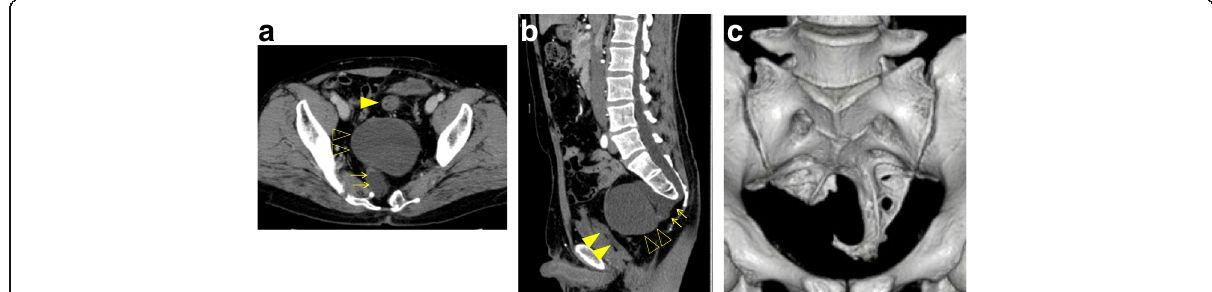
Fig. 1 Computed tomography (CT) scan showing a 60 × 30 × 21-mm meningocele ( → ) which was protuberated anteriorly from the level of S3; a 90 × 85 × 68-mm mass ( △ ) which was located anterior to the meningocele; and a dislocated rectum ( ▲ ) ( a , b ). A partial defect of the sacrum with deformity was detected ( c )